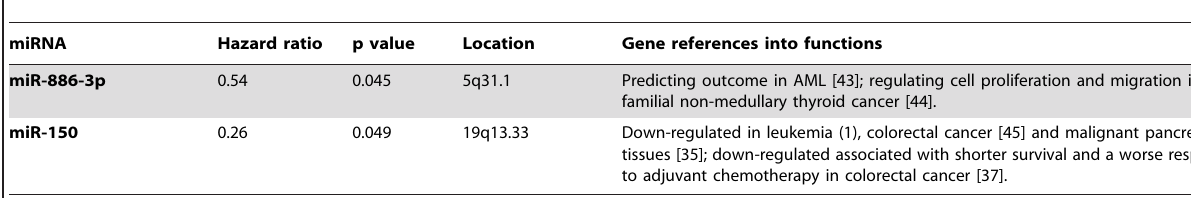
Table 2. microRNAs associated with overall survival in